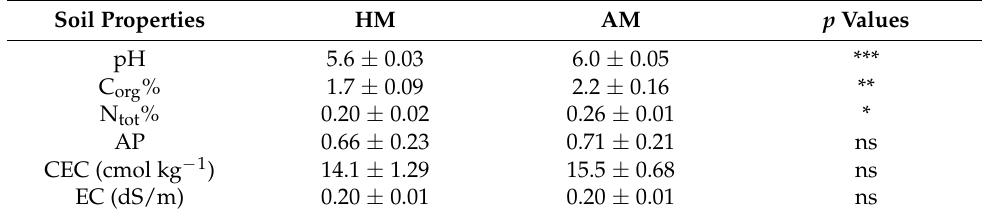
Table 3. Soil properties of hay (HM) and abandoned (AM) meadow. Data are means of 16 samples ± SE. Asterisks represent significance of p < 0.05 (*); p < 0.01 (**); p < 0.001(***),